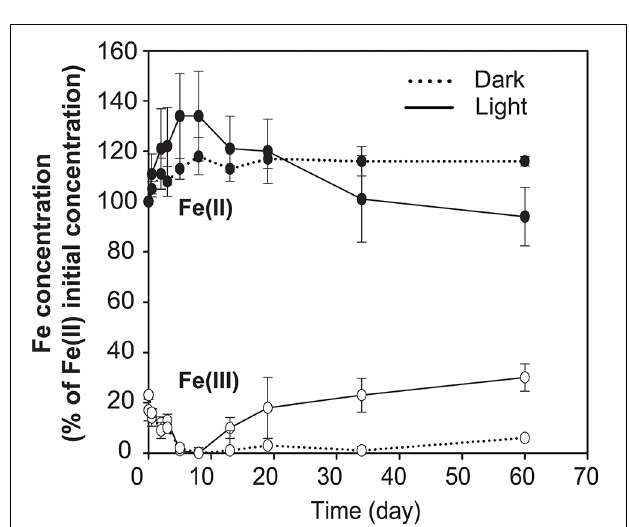
in absence of oxygenic photosynthesis (with DCMU addition). For both experimental settings, light conditions involved consecutive periods of 12h illumination at 61 µ E m − 2 s − 1 and 12h darkness. Solid symbols stand for Fe(II) and open symbols for Fe(III) concentrations. The dotted lines represent means of killed controls (stars; n = 3).